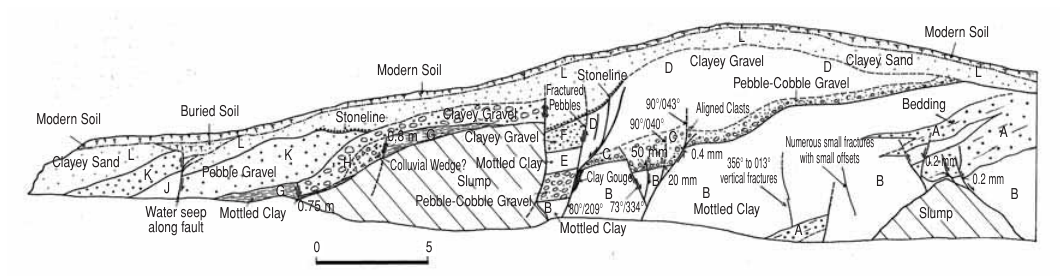
Fig. 12. Log of south-facing exposure of faulted alluvial gravels and lacustrine clays at the southern end of the Pua Fault. Overall sense of displacement is down-to-the-west. Scale in